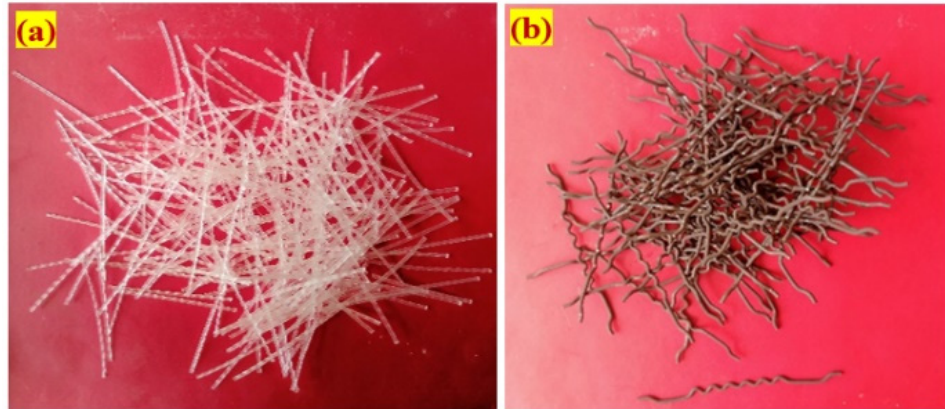
Figure 4. The appearances of each fibre ( a ) Polypropylene ( b ) Steel.